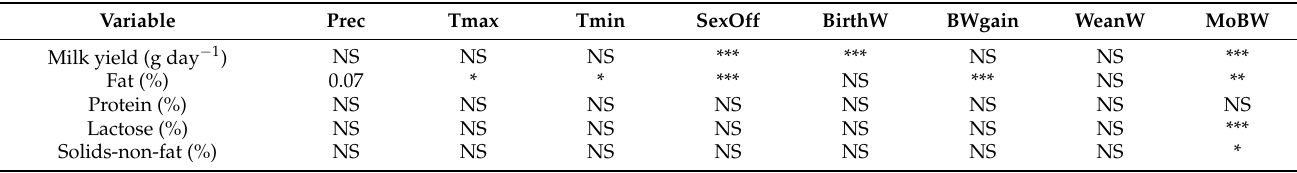
Table 3. The relationship among milk composition (fat, protein lactose, and solids-non-fat) and environmental conditions, progeny growth variables, and maternal body weight from non-supplemented goats reared on a Xerophytic ecosystem in northern Mexico during winter–spring with different milk yielding potentials (medium vs. low). The data from goats with different milk yielding potentials are